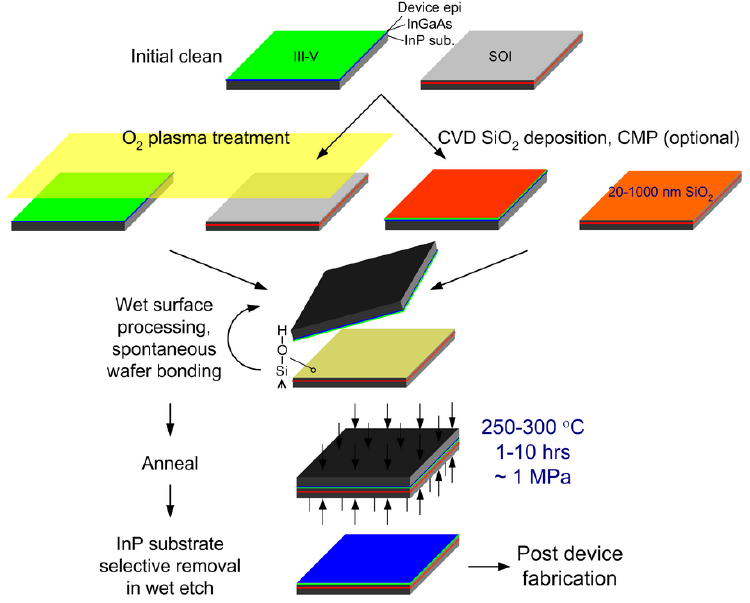
plasma-assisted and SiO 2